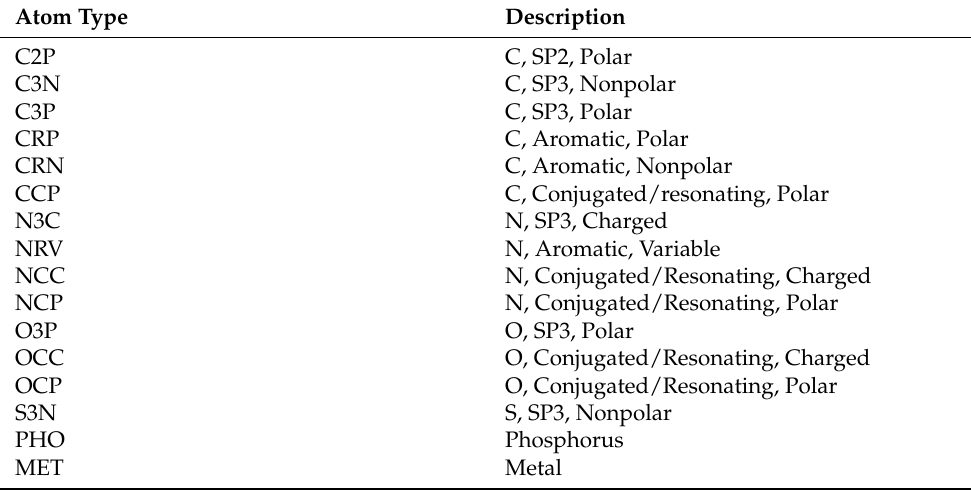
Table 4. Atom types and